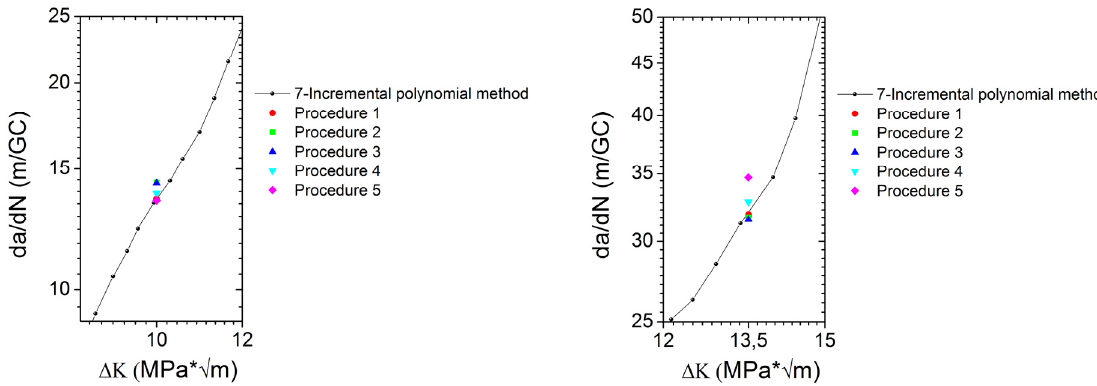
Figure 14: Comparison among crack growth rates corresponding to the different  K.